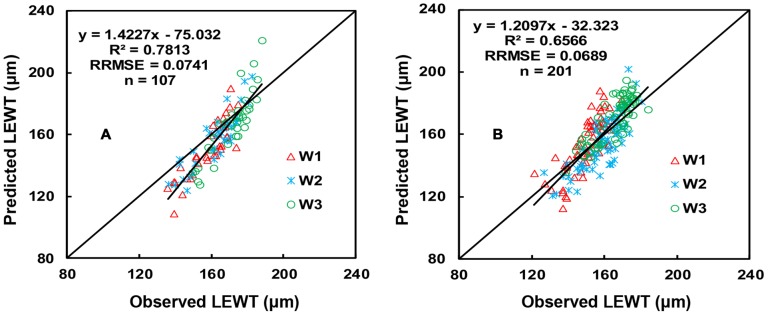
Quantitative relationships between NDSIe (R1445, R487) and LEWT before anthesis (A); quantitative relationships between NDSIt (R1714, R1395) to LEWT after anthesis (B).